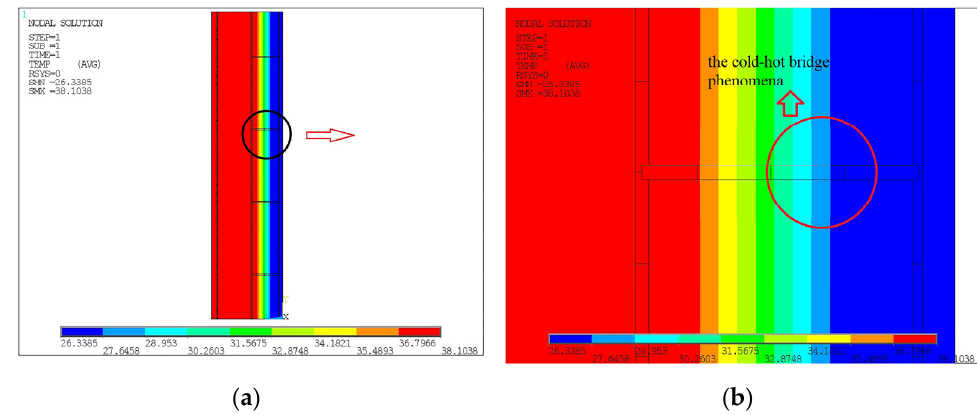
Figure 18. S-80XPS temperature contour of the section: ( a ) overall rendering; ( b ) partial enlargement. Note: X, Y, and Z are the directions of the coordinates.